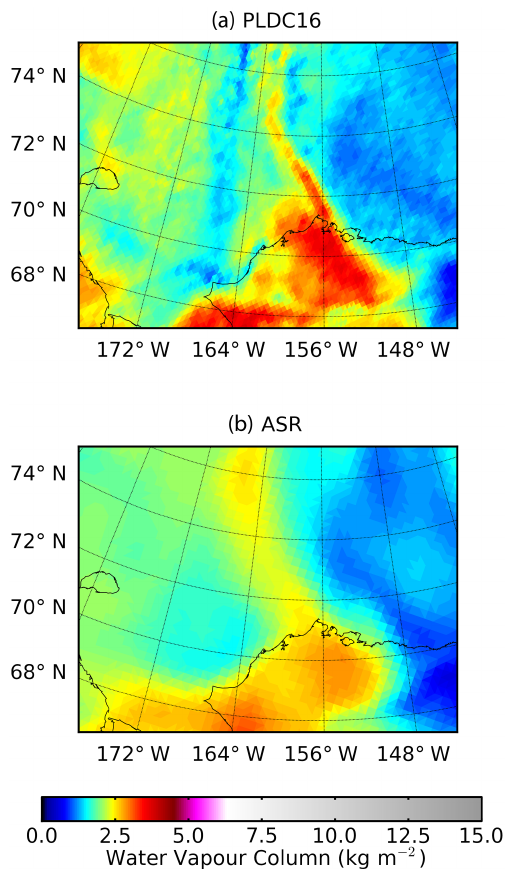
Figure 7. The spatial distribution of water vapour column centred over the Chukchi Sea north of Barrow, Alaska: (a) the PLDC16 re- trieval from NOAA-18 MHS brightness temperature measurements on 31 January 2008 at 23:09UTC; and (b) the Arctic System Re- analysis (ASR) product for 1 February 2008 at 00:00UTC.